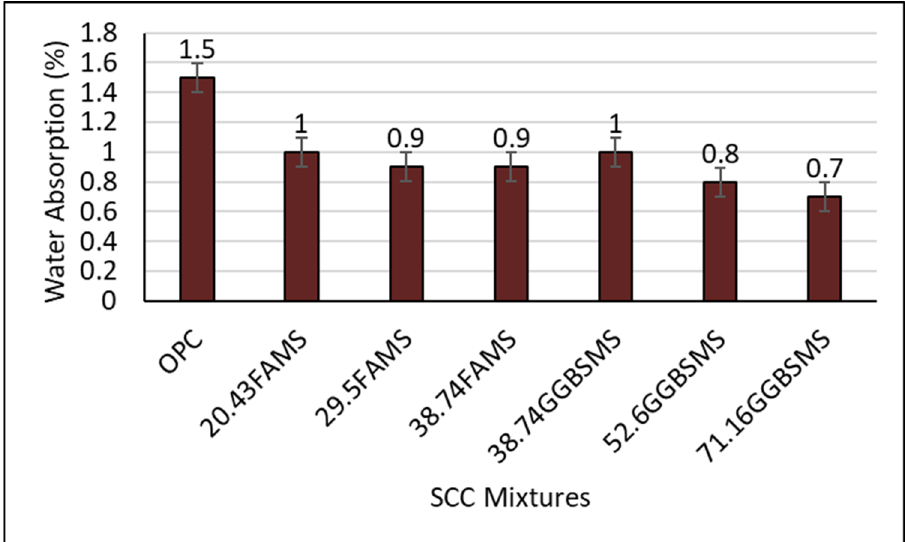
Figure 16. Water absorption of SCC mixtures at 28 days.